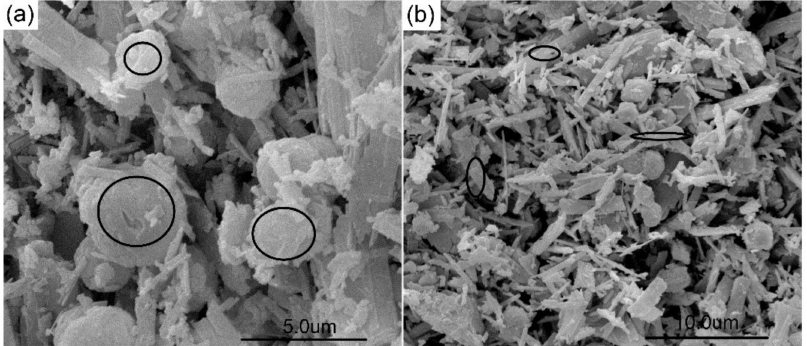
Figure 8. SEM magnified image of L–6: ( a ) spots of energy dispersive X-ray spectroscopy (EDS) for spherical particle; ( b ) spots of EDS for laminar particle. EDS were determined for the spots in the black